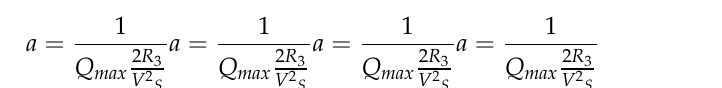
Figure 7. Proposed hierarchical control for ES-2.